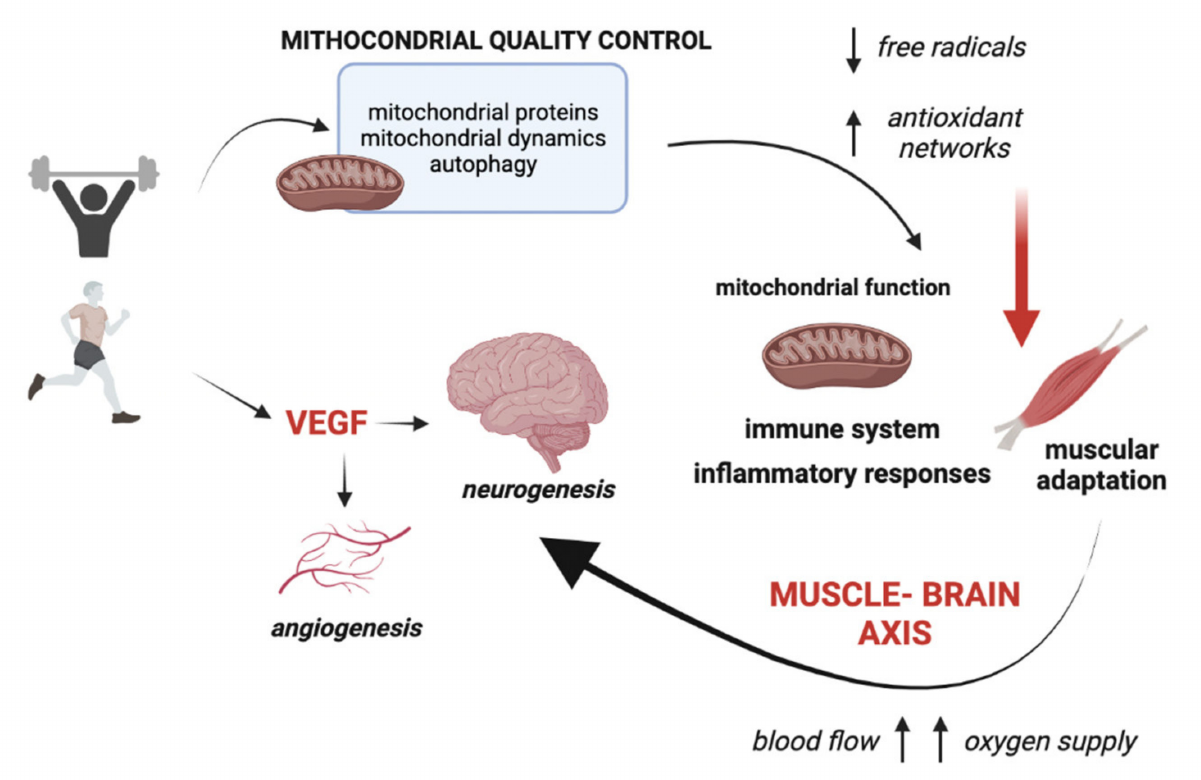
Figure 2. Mechanisms mediating the beneficial effects of specific training programmes on the muscle–brain axis. Resistance and aerobic training improves mitochondria function, immune system, and inflammatory response by improving mitochondria quality control, which leads to muscular adaptation, brain neurogenesis, and angiogenesis. Figure created using BioRender